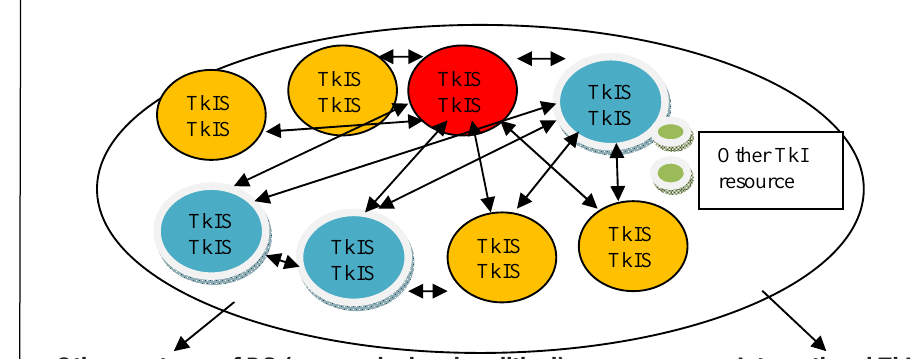
Figure 2 – General model of the telecommunications and information system in the Republic of Serbia (Generalštab Vojske Srbije & Medija centar „Odbrana“, 2012) Рис . 2 – Общая модель информационной и телекоммуникационно систем в Республике Сербия (Generalštab Vojske Srbije & Medija centar „Odbrana“, 2012) Слика 2 – Општи модел телекомуникационо - информационог система у Републици Србији (Generalštab Vojske Srbije & Medija centar „Odbrana“,